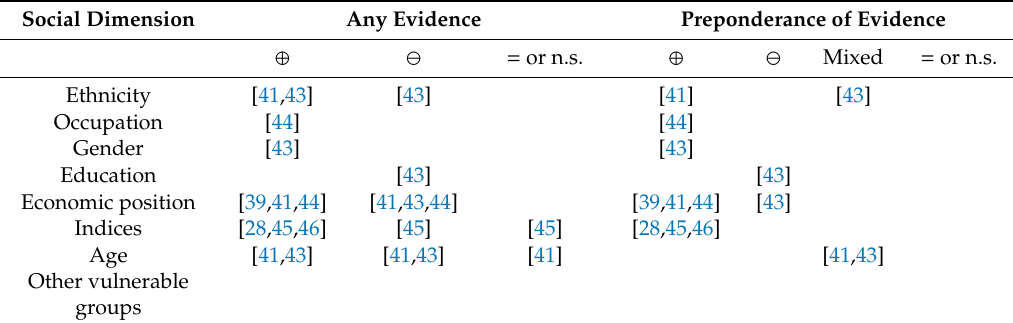
Table 3. National or international studies with sub-national data